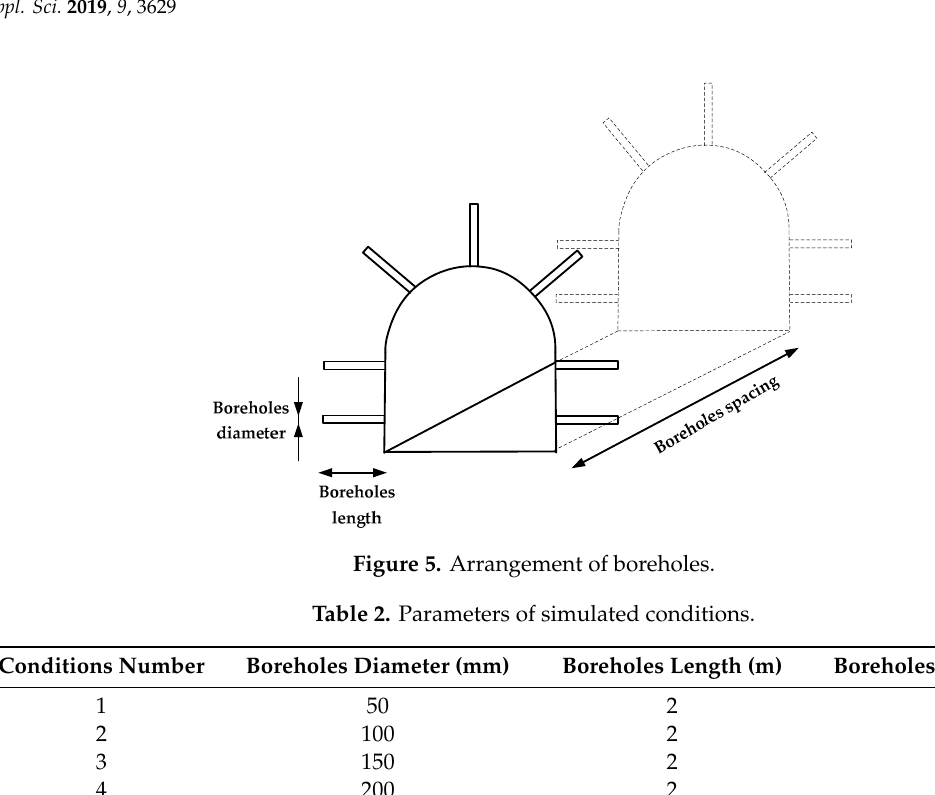
6 of 17 Figure 4. Three-dimensional numerical model. Table 1. Mechanical parameters of surrounding rock. Density ρ (kg/m 3 )